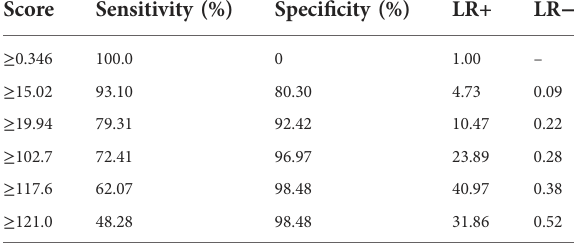
TABLE 5 Cutoff values and diagnostic ability for DDH.